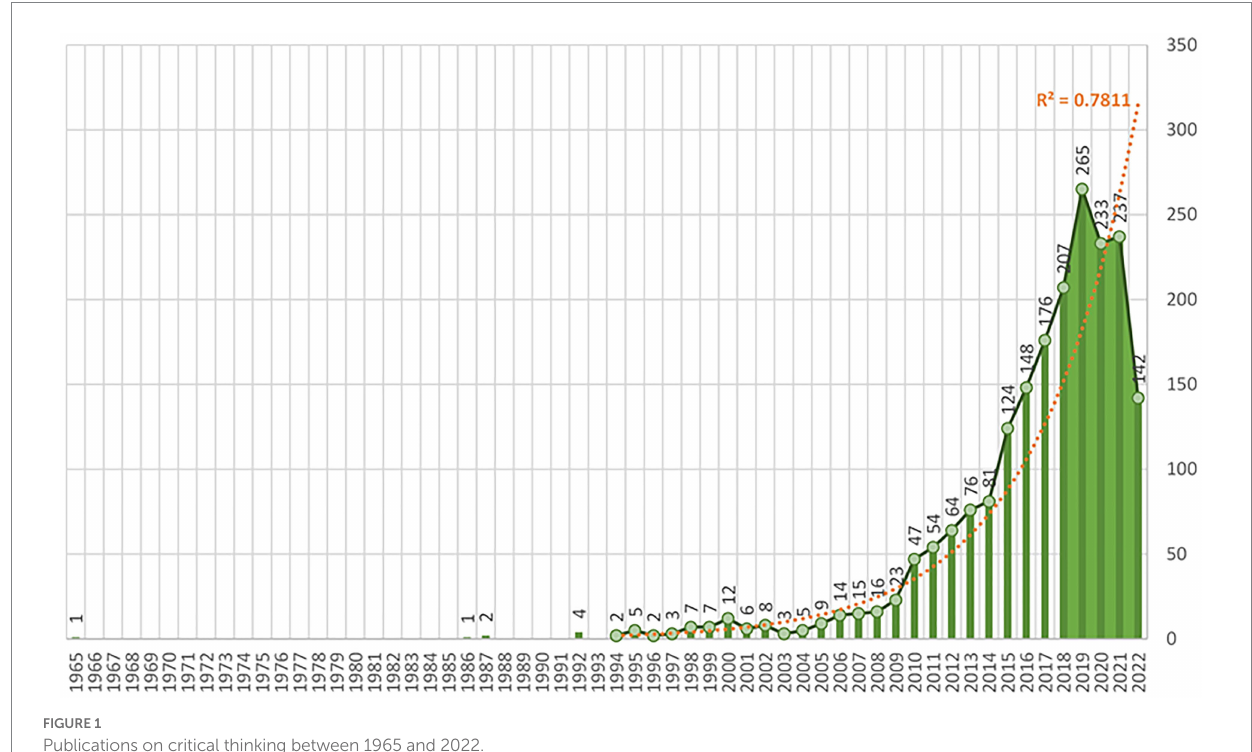
FIGURE 1 Publications on critical thinking between 1965 and 2022.